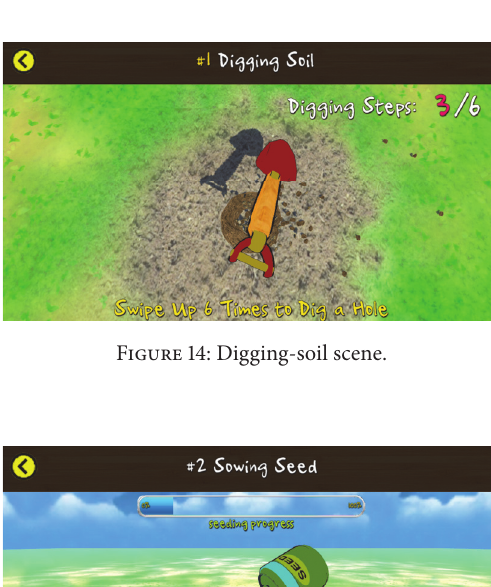
Figure 11: Little Botany garden with tile map structure.